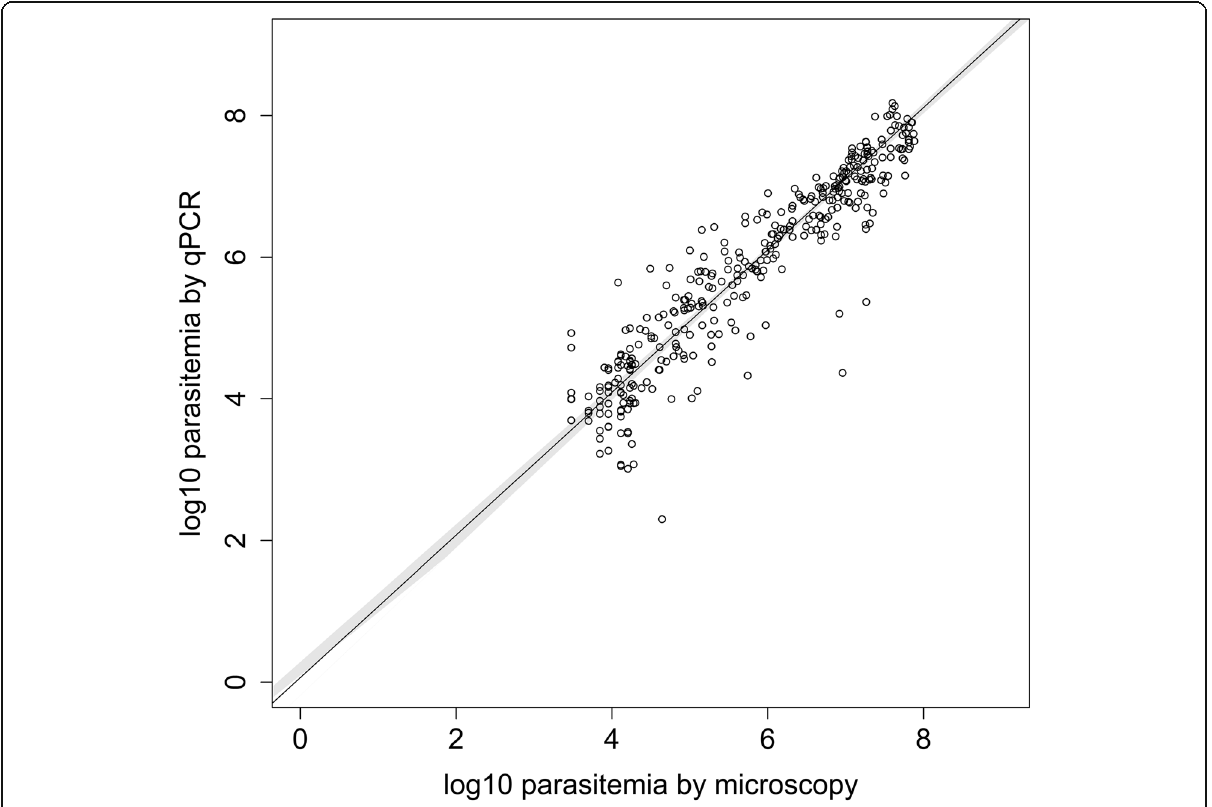
Fig. 1 Passing – Bablok regression fit comparing microscopy and 18S qPCR. The plot shows log 10 parasitemia by microscopy and 18S qPCR. The solid black line represents the fitted Passing – Bablok regression line. The 95% confidence bounds, in grey, were calculated using the